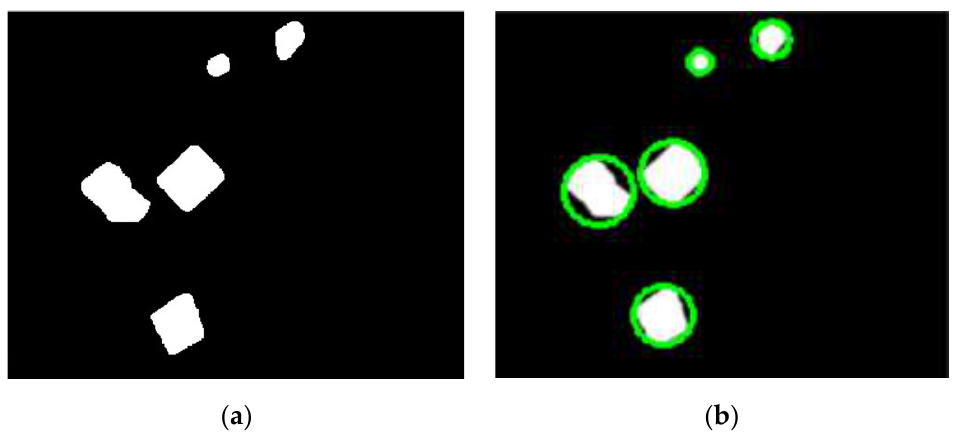
Figure 4. An example with minimum enclosing circle method: ( a ) the binary image with multiple objects; ( b ) the result of minimum enclosing circle.